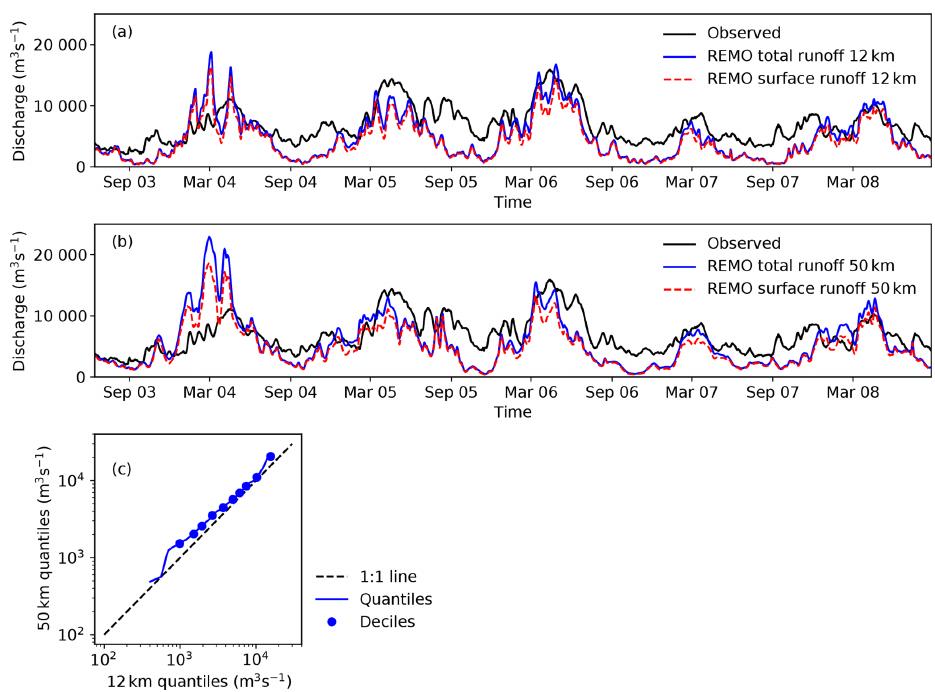
Figure 7. Hydrographs for the Danube basin at the gauging station Ceatal Izmail. Hydrographs were obtained by routing runoff output from the regional climate model REMO with mRM, employing the adaptive time step parameterisation (aTS) at spatial resolutions of 12km (a) and 50km (b) . The solid black line shows the observed streamflow. The solid blue line is mRM output using the sum of the REMO surface and subsurface runoff components as input. The dashed red line is mRM output using only the REMO’s surface runoff component. Panel (c) quantile–quantile plot of the routed REMO outputs (sum of surface and sub-surface components) at 12 and 50km